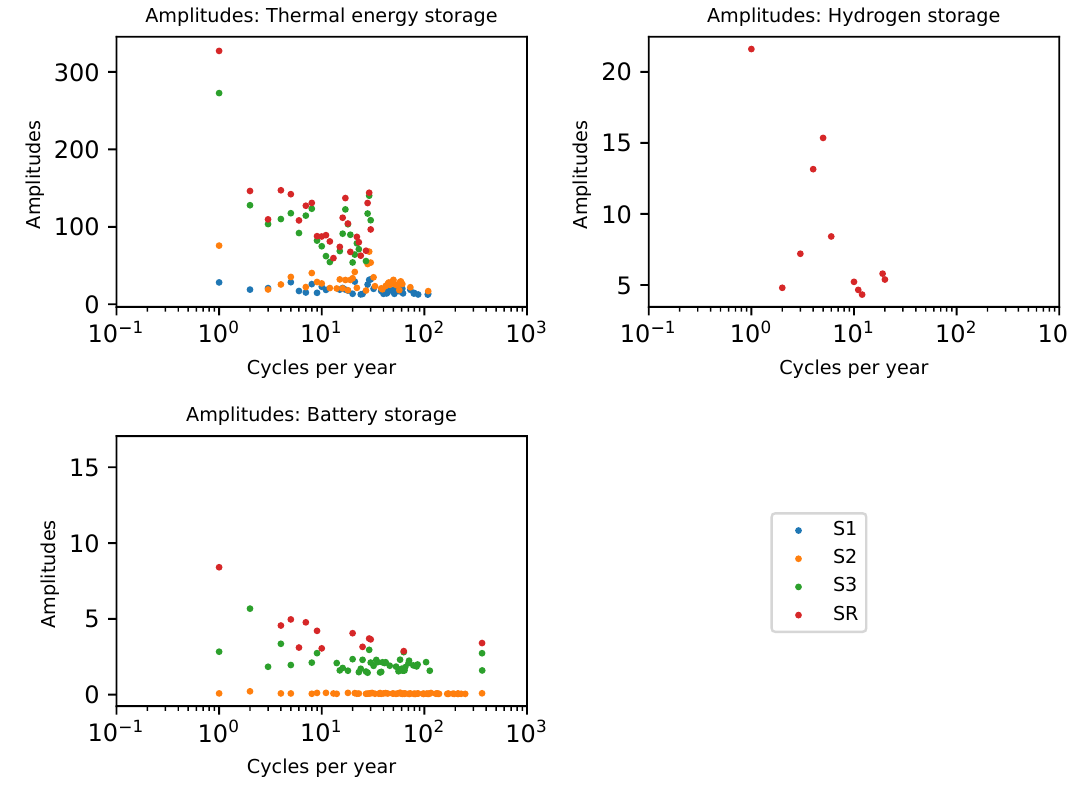
Figure 10. Periodical components of the state of energy. (Source: own